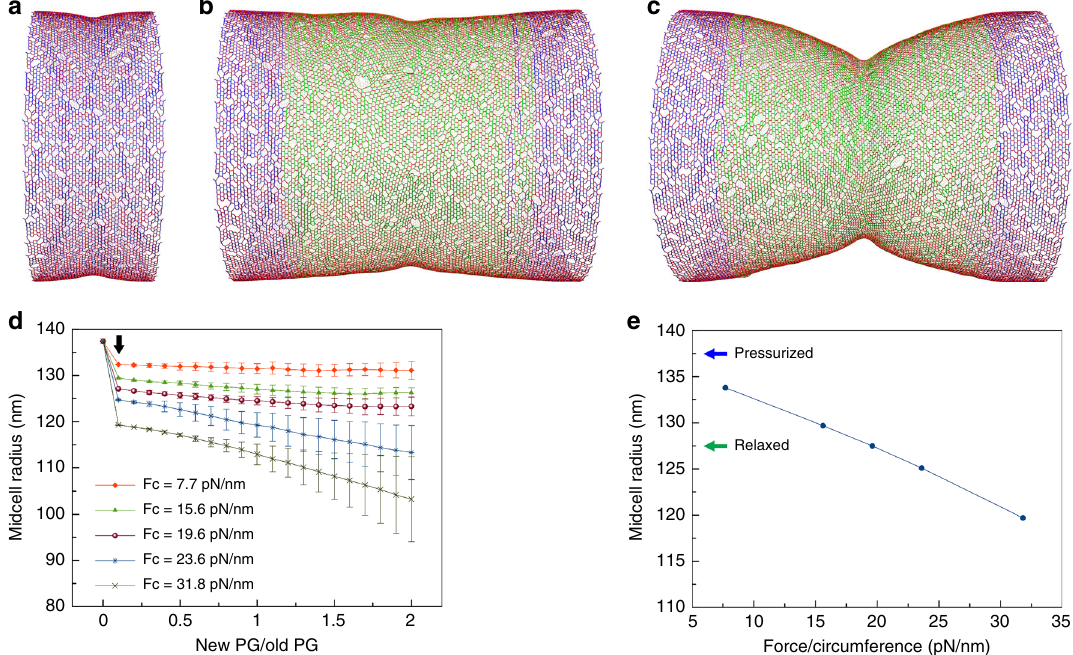
Fig. 2 Cell wall synthesis under constrictive force. a A snapshot of the peptidoglycan (PG) cylinder showing that the force caused an initial constriction at the midcell before insertion of new PG. b A snapshot of the sacculus after new PG was inserted showing that when the force per circumference was F c = 15.6pN/nm, further constriction did not occur as new PG was inserted. c When F c = 31.8pN/nm, constriction occurred as new PG was inserted. d Pro fi les of the midcell radius with respect to the amount of new PG inserted show that PG insertion-induced constriction occurred only if F c was >19.6pN/nm. The arrow indicates the initial constriction by the force before new PG insertion started. Each trace presents the average of four simulations. Error bars indicate standard deviation. e The dependence of the midcell radius on the force before new PG was inserted shows that the midcell became relaxed at F c = 19.6 pN/nm. The blue arrow indicates the radius before the force was applied. The green arrow indicates the radius of a relaxed cell wall